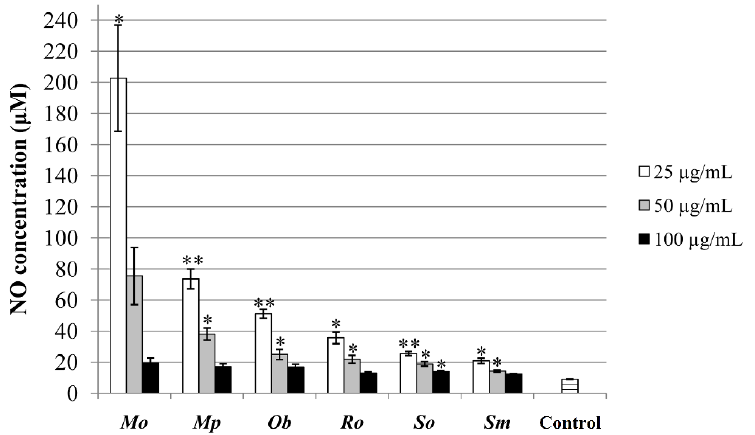
Figure 6. Griess assay performed in the extracts’ concentrations of 25, 50, and 100 µg/mL and expressed as the concentration of nitric oxide (NO). * p < 0.05; ** p < 0.01—statistically significant increase in NO production by HCT-116 cells in comparison with the untreated control.